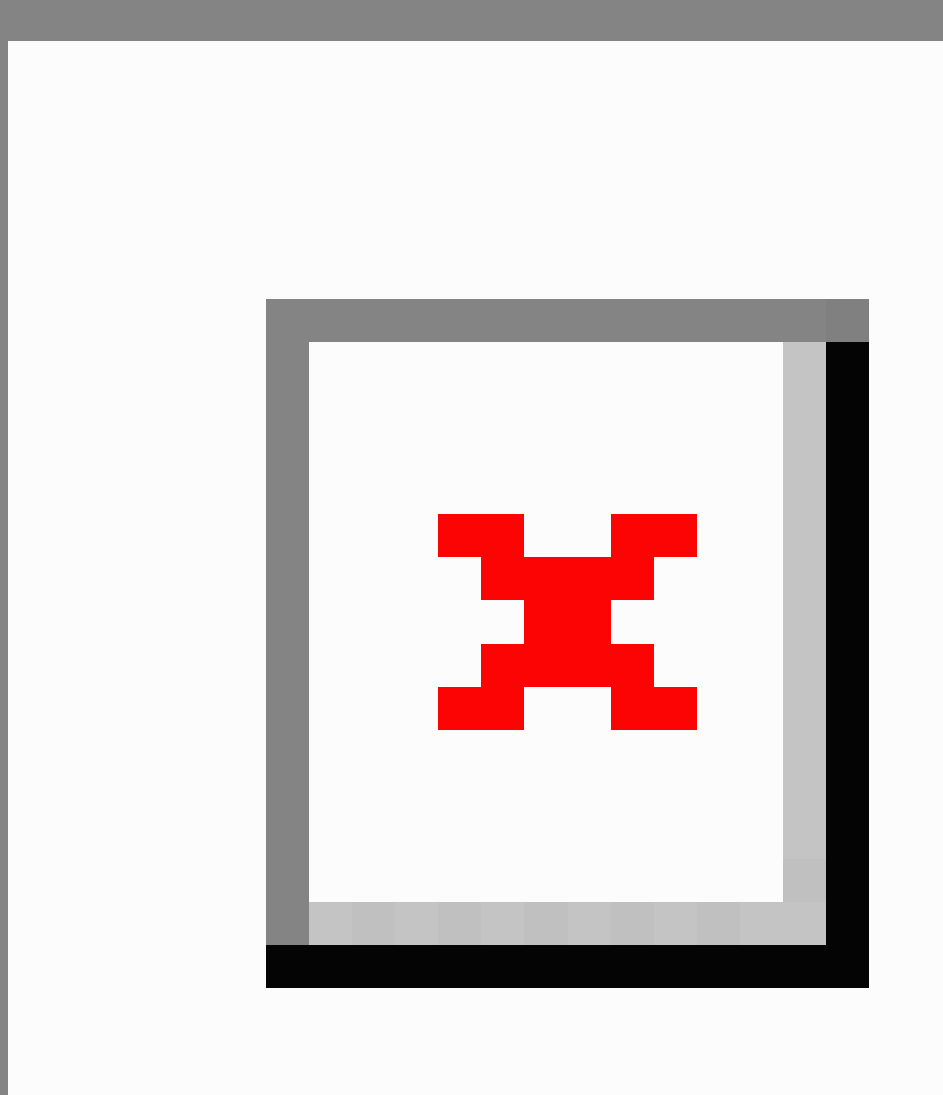
Figure 1. The wireless insole for independent and safe elderly living (WIISEL)